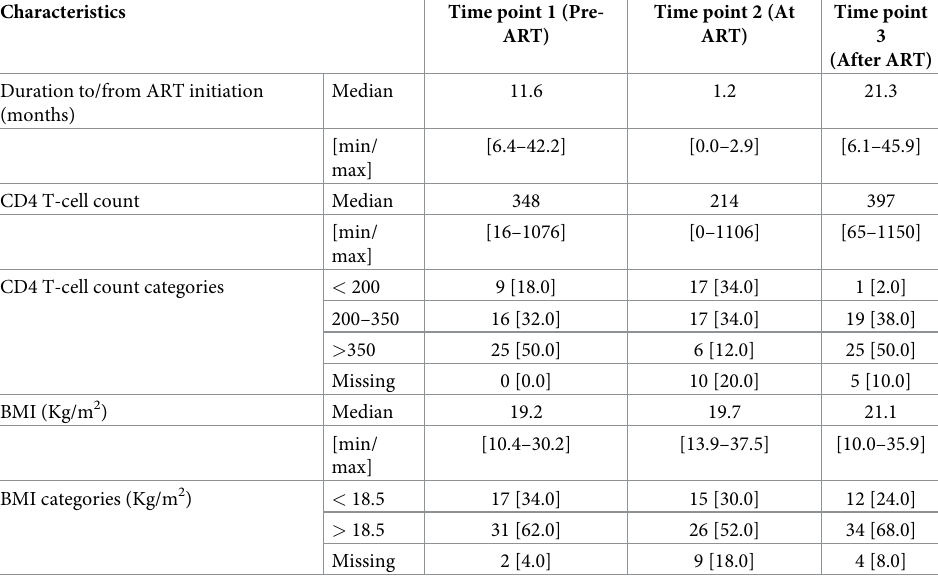
Table 2. Distribution of clinical parameters amongst eligible participants over the three time points included in the analysis from rural Coastal Kenya (N = 50).